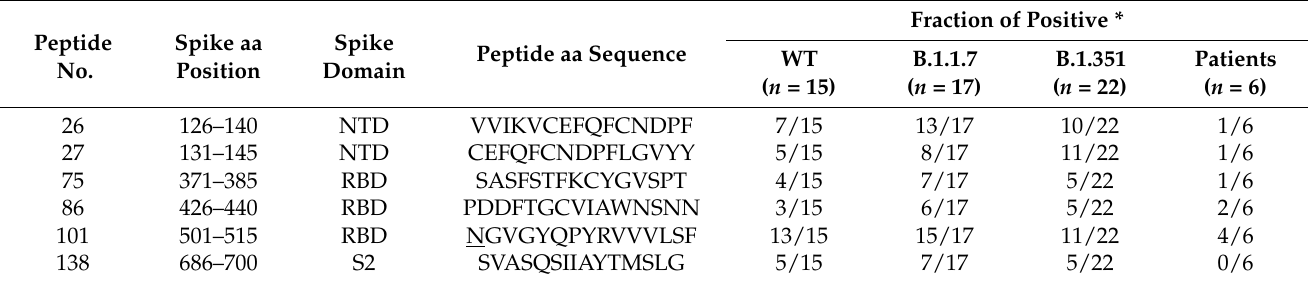
Table 1. Fraction of “positive” linear peptides detected by sera obtained from infected mice with the three SARS-CoV-2 isolates and among human patients.